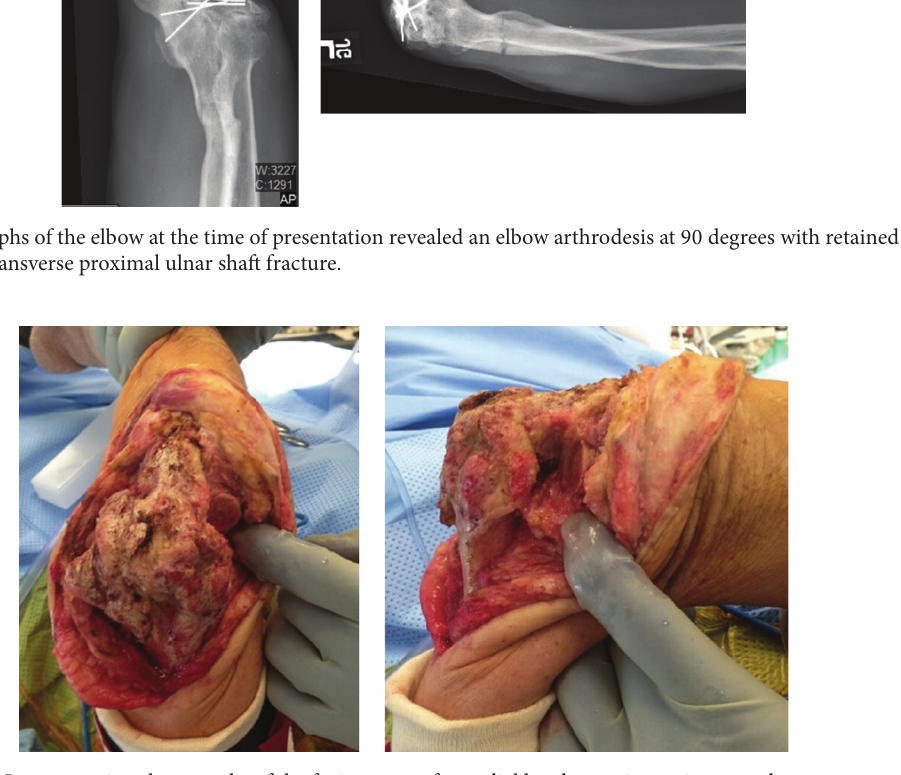
Figure 2: Intraoperative photographs of the fusion mass after radial head resection, prior to wedge